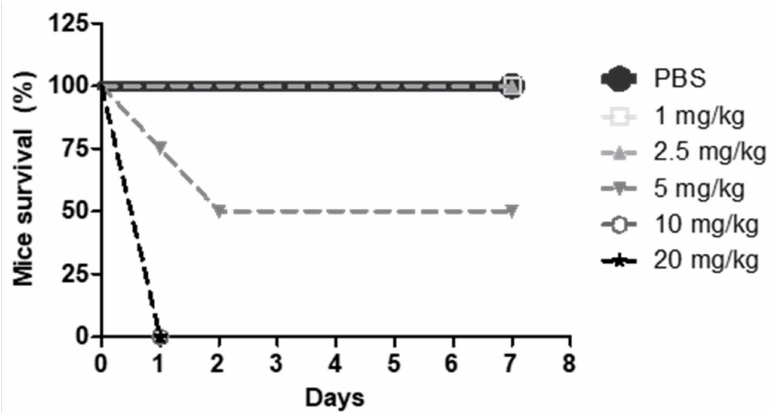
Figure 5. CD1 mice survival after i.v. application of G2-S16 dendrimer. CD1 mice were injected with G2-S16 dendrimer at different concentrations, and PBS as innocuous control. Survival of the mice after application is plotted as percentage of treated mice alive at each time point. Each group was formed by 4